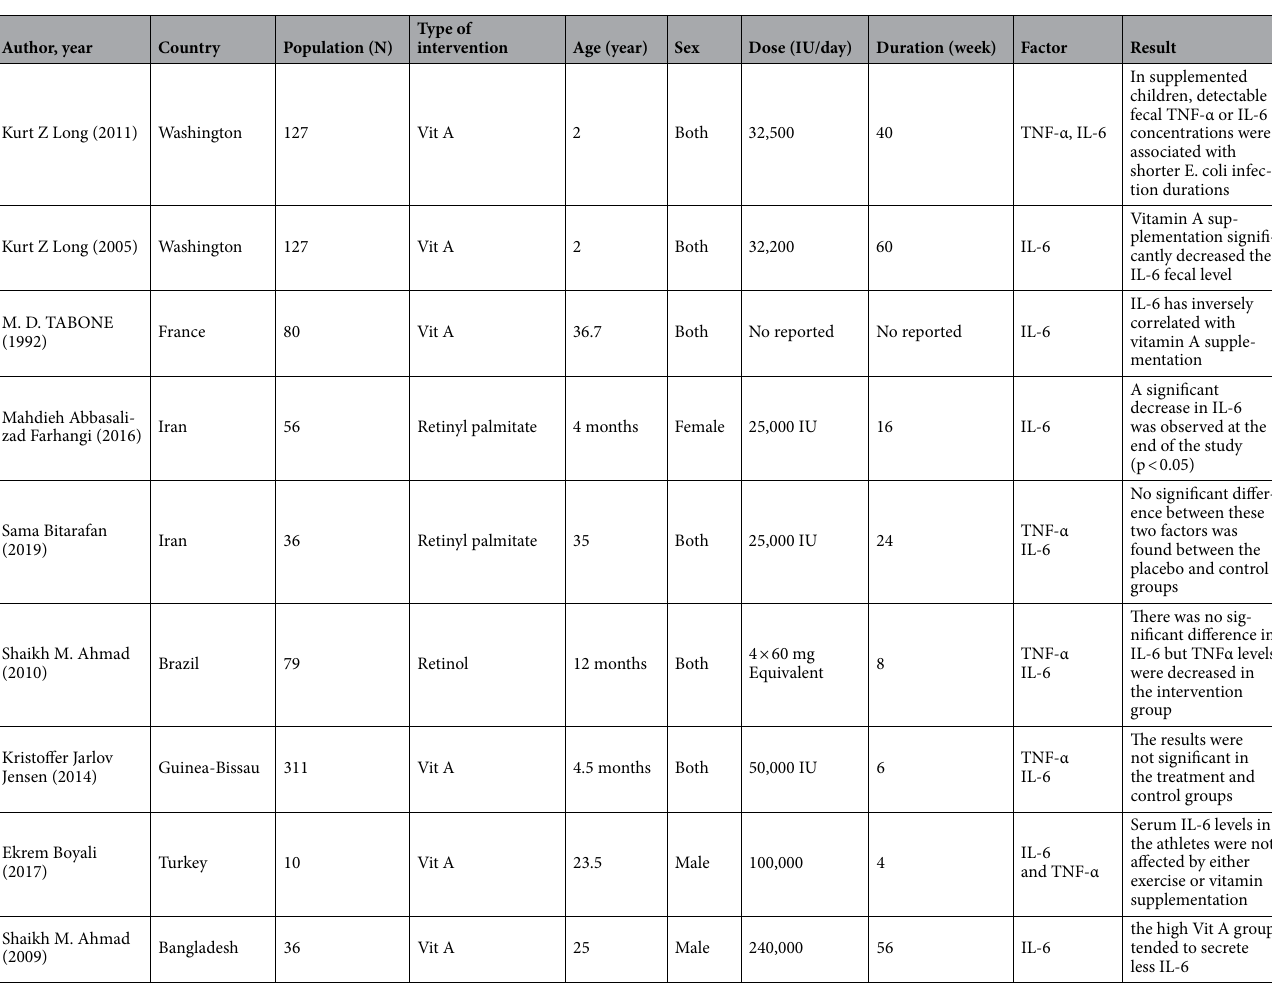
Table 4. The effect of vitamin A on TNF-α and IL-6 in review studies. Summary of clinical trials on the effects of vitamin A supplementation on inflammatory biomarkers (IL-6 and TNF-α). IL-6 interleukin 6, TNF-α